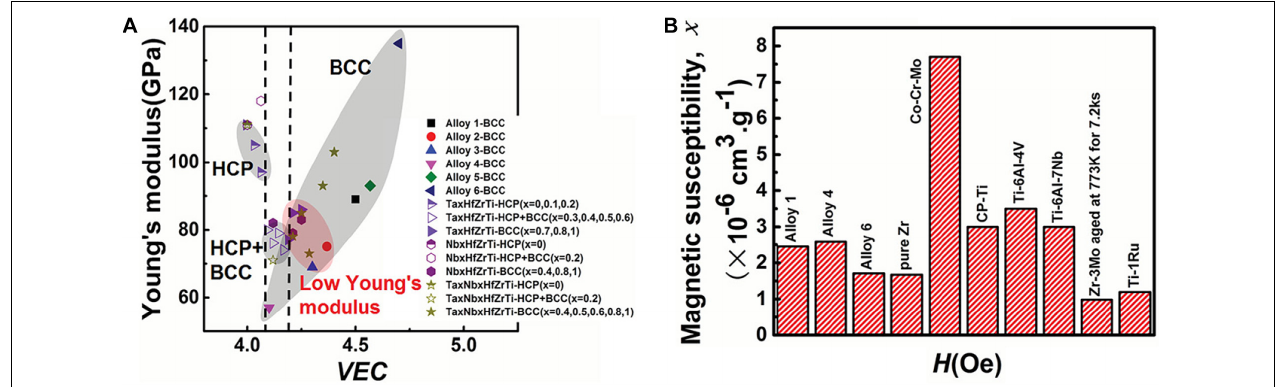
FIGURE 1 | Performance comparison of titanium-based HEAs and other metallic alloys, (A) Dependence of Young’s modulus and crystalline phase structure on VEC in all the HEAs investigated. (B) Comparison of magnetic susceptibilities of alloys 1, 4, 6, and pure Zr with the alloys commonly used in medical devices. (Alloy 1: